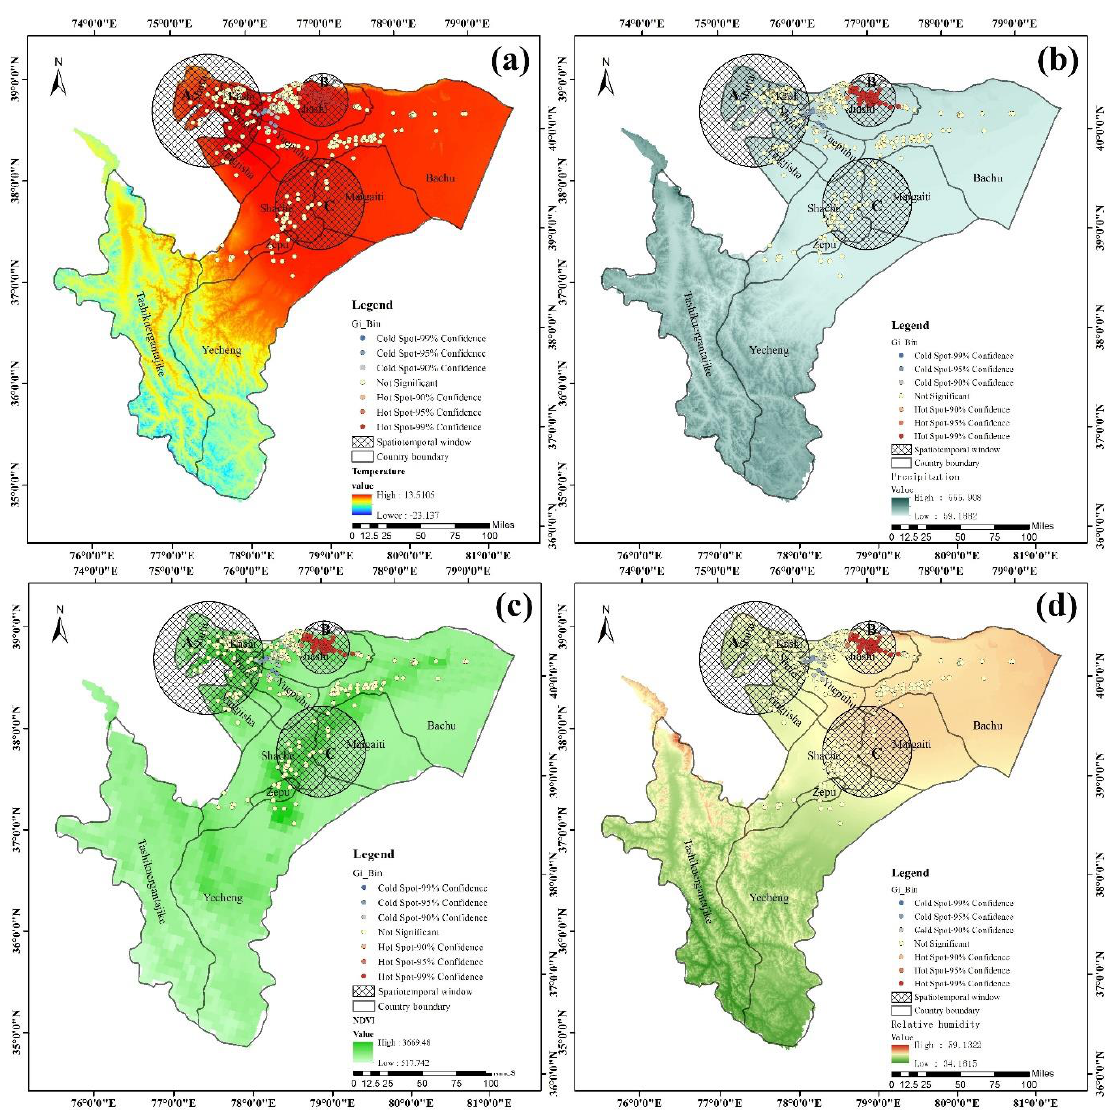
Figure 6. Mapping showing the relationships between VL cases ’ distribution and environmental factors. Note: ( a ) represents the annual average temperature, ( b ) represents the annual average precipitation, ( c ) represents the annual average normalized difference vegetation index (NDVI), and ( d ) represents the annual average relative humidity from 2005 to 2017.